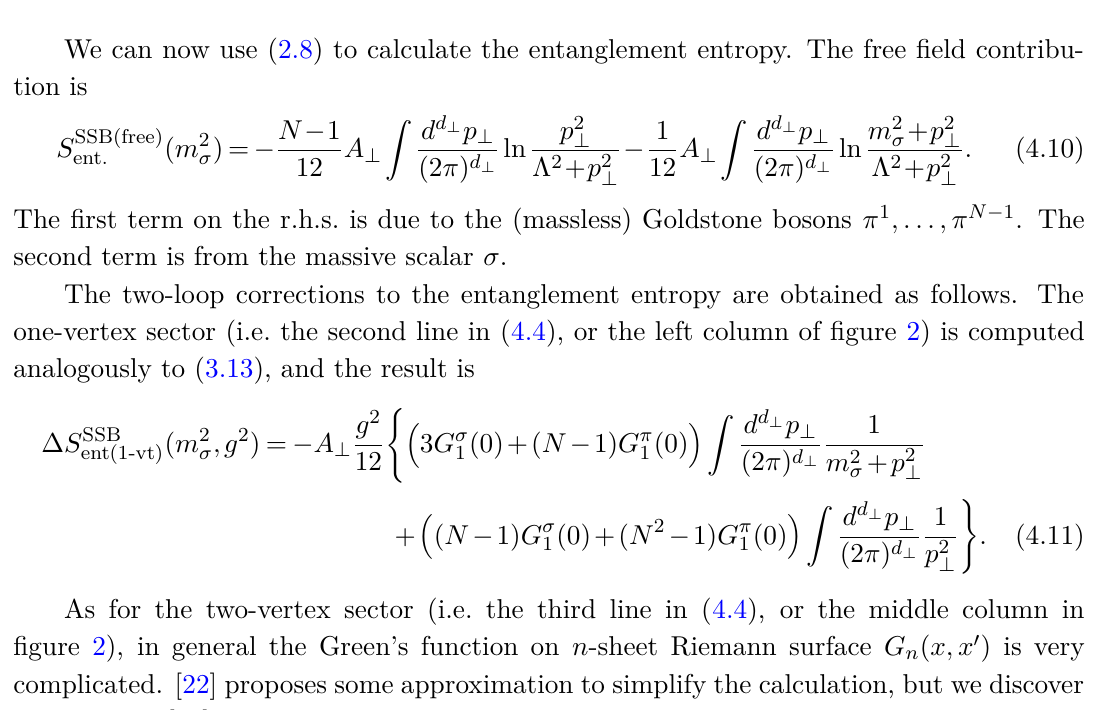
Figure 3 . Feynman diagrams for the mass renormalization of π i ’s (the upper row) and σ (the lower row). The left column represents the contribution from the quartic interactions, while the middle one from the cubic interactions. The right column stands for the counter terms. The solid lines denote σ while the dashed lines π i